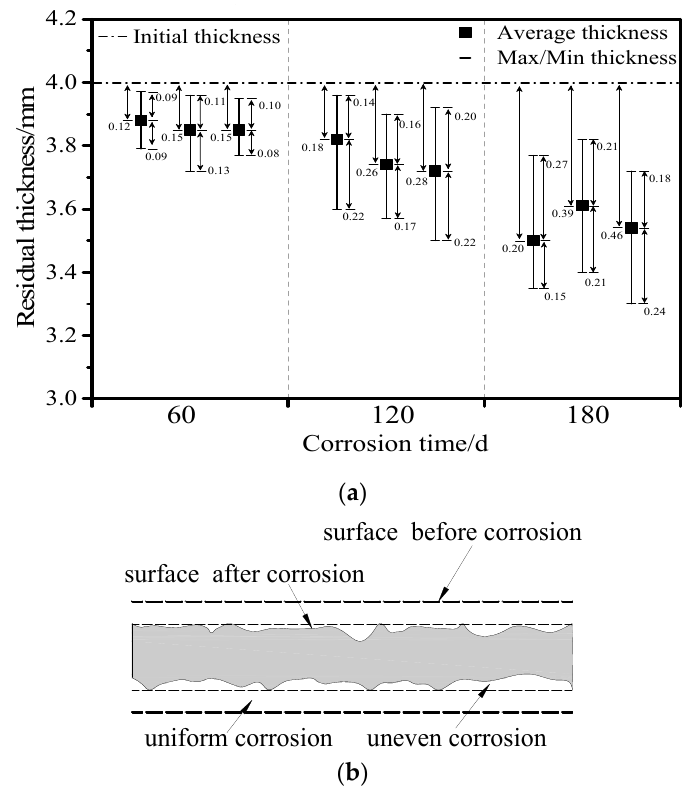
Figure 7. Residual thickness: ( a ) Residual thickness and corrosion time, ( b ) Corrosion diagram.